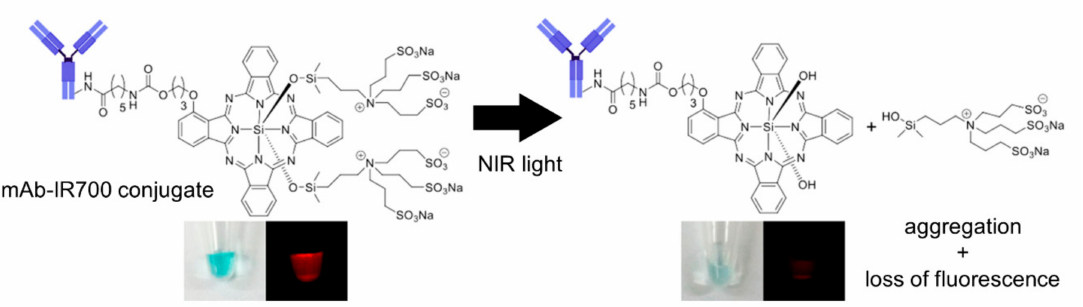
Figure 1. Scheme of IR700 chemical structure and its conformational change upon NIR light irradia- tion. Adapted with permission from Ref. [7]. Copyright 2018 American Chemical